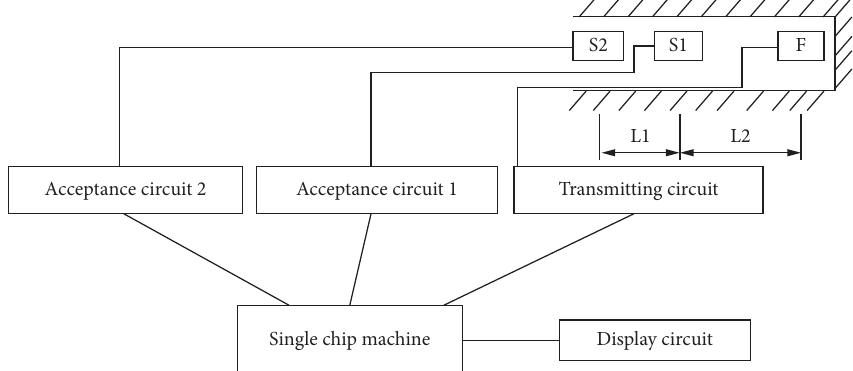
Figure 11: Schematic diagram of ultrasonic surrounding rock fracture tester.